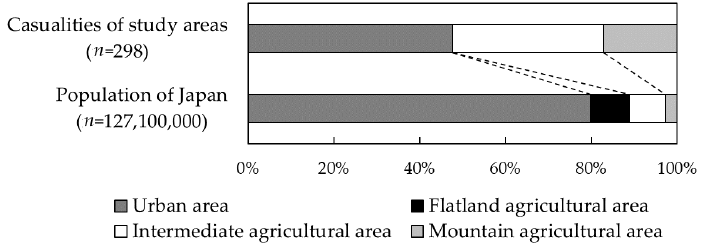
Figure 3. Proportion of casualties among the study areas and proportion of nationwide population, stratified according to agricultural area type. (Date sources: [14,25,28]).